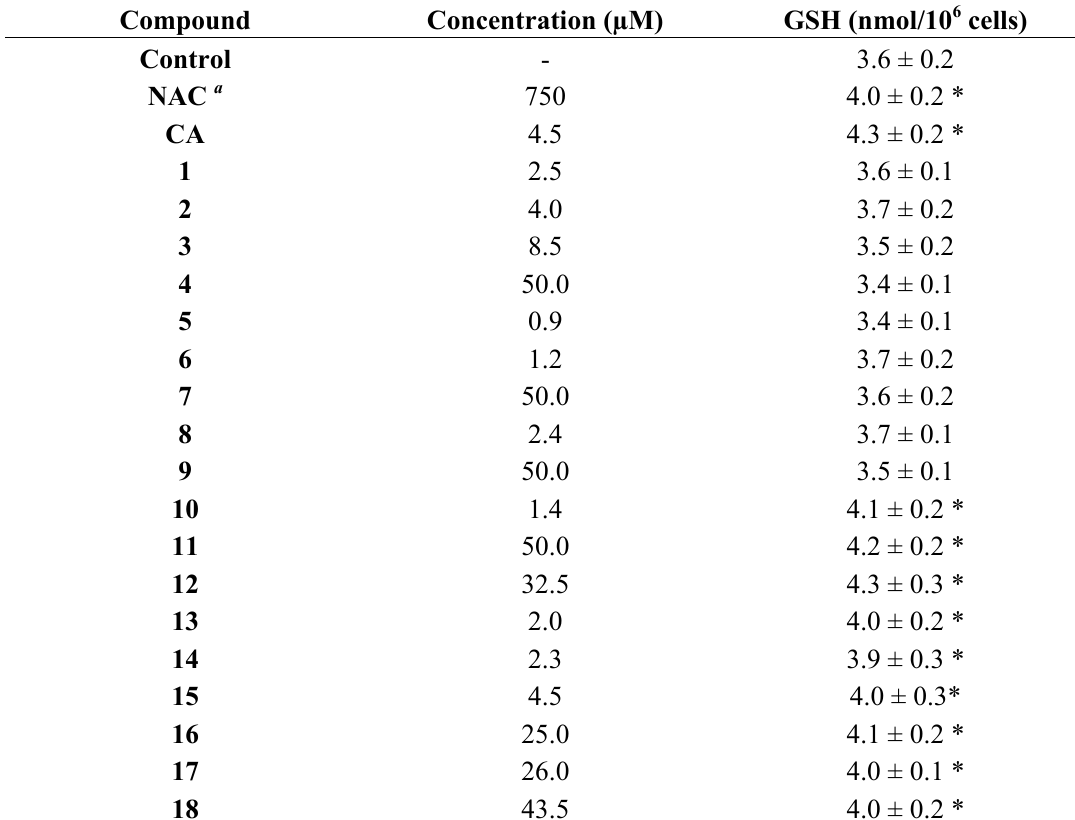
/20) during 12 50